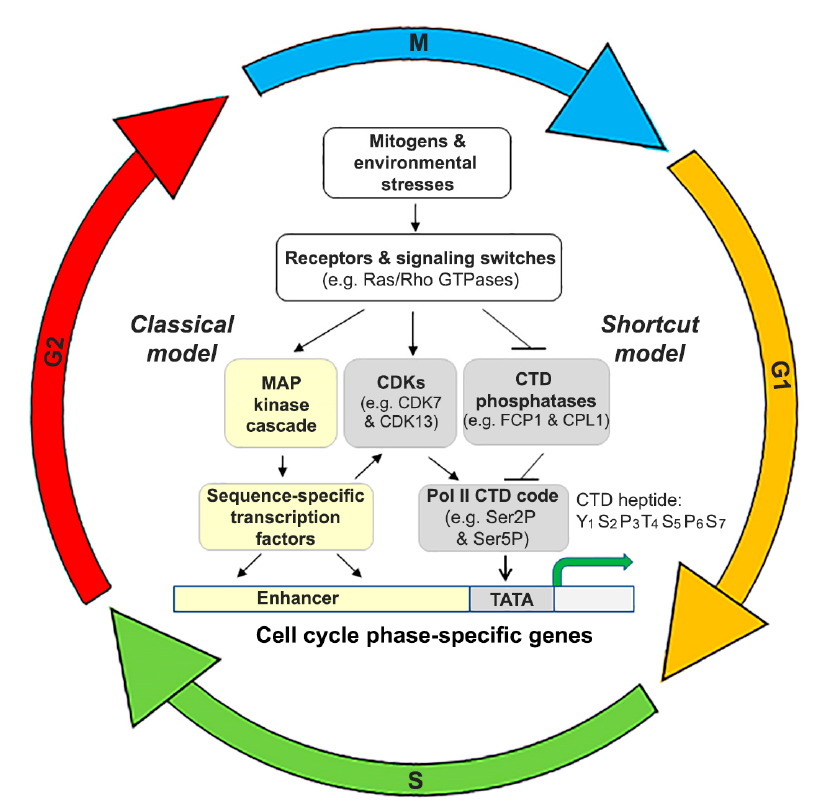
Figure 4. A proposed cooperative mechanism of Pol II transcriptional control via integration of the classical and shortcut models. Spatial and temporal transcription control of cell cycle phase-specific genes is conferred by sequence-specific transcription factors, which are activated by the classical model and consequently bind to the enhancer of those cell cycle genes. Direct modulation of the Pol II CTD code via regulating the abundance or activity of CDKs and CTD phosphatases allows Pol II, which recognizes the core promoter including the TATA box, to undergo productive